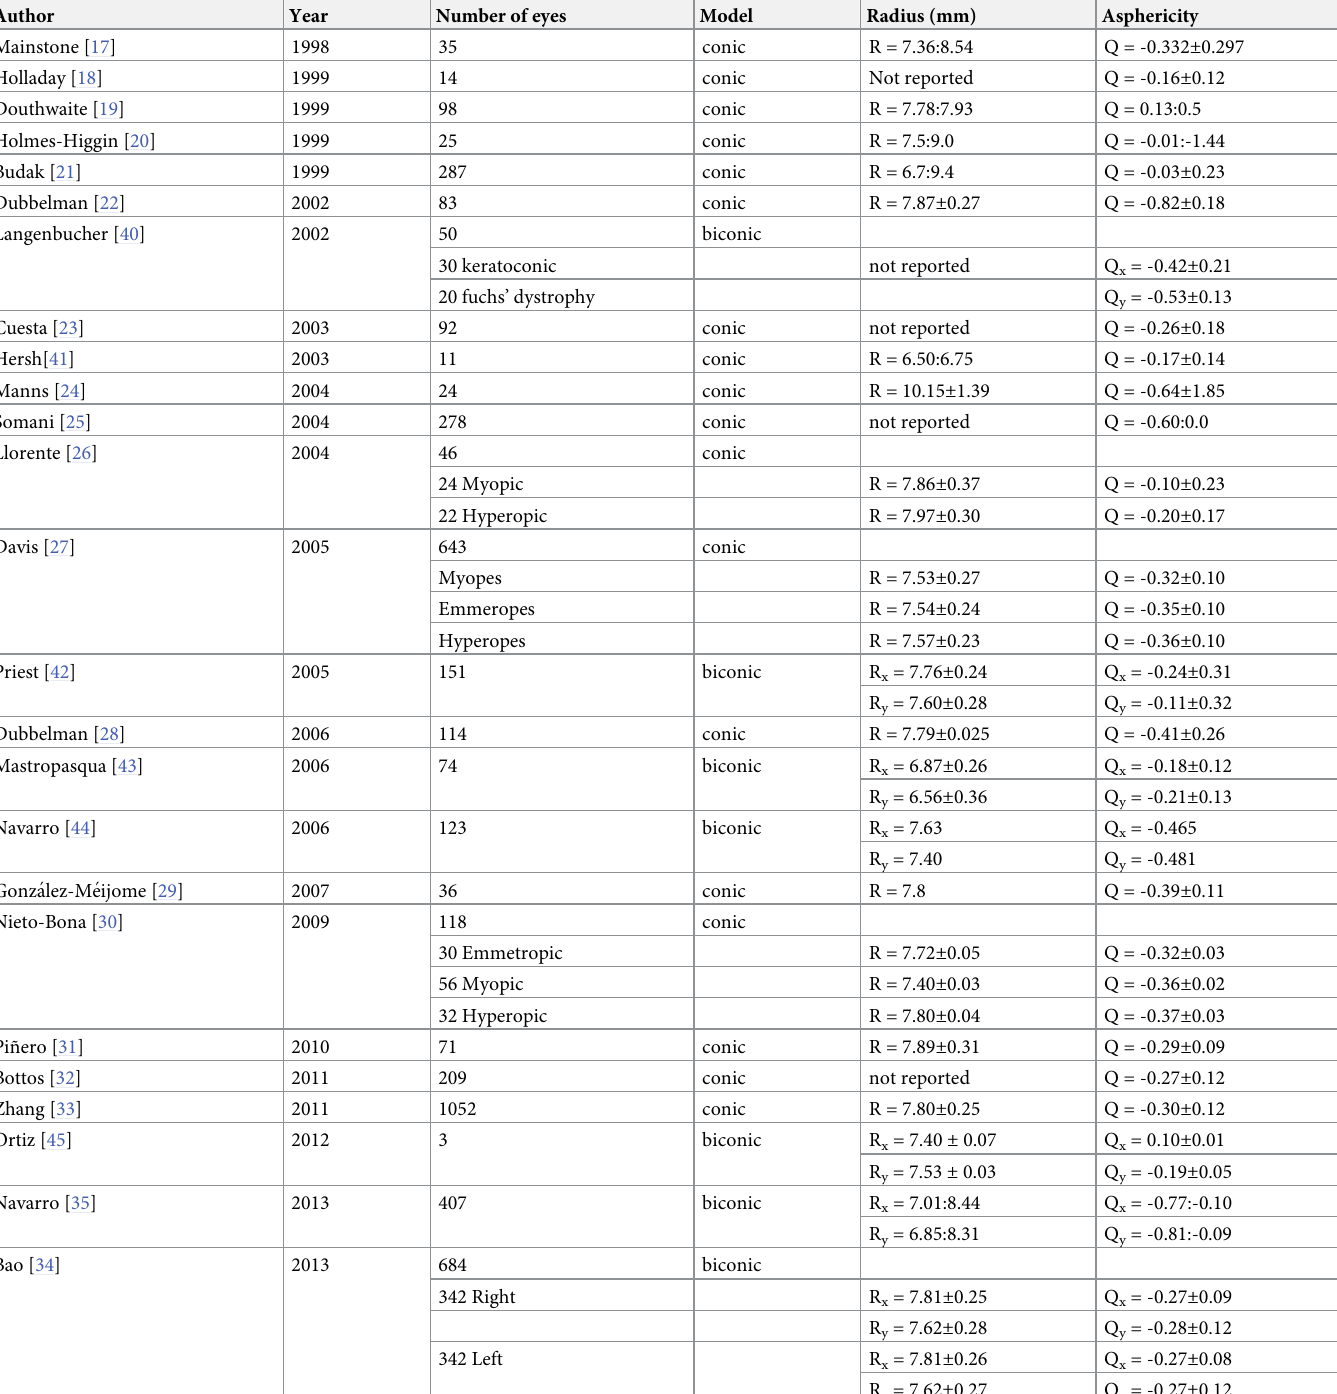
Table 1. Summary of the anterior corneal radius and asphericity as reported in the